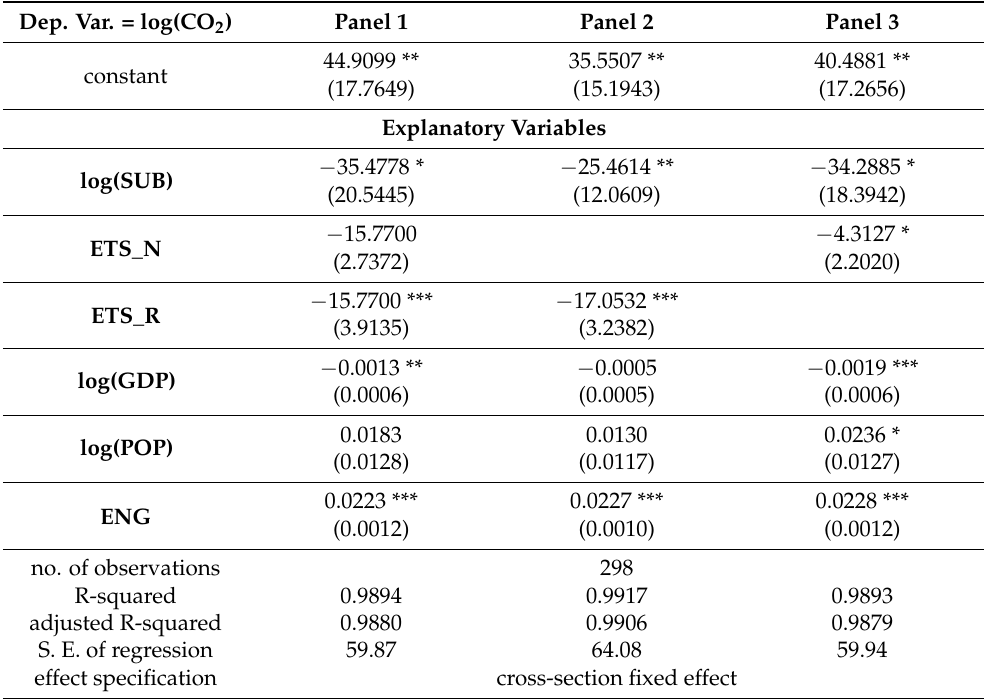
Table 4. Estimation results of the panel regression